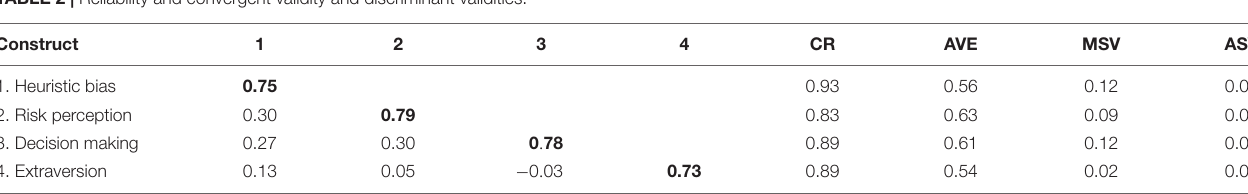
TABLE 2 | Reliability and convergent validity and discriminant validities.